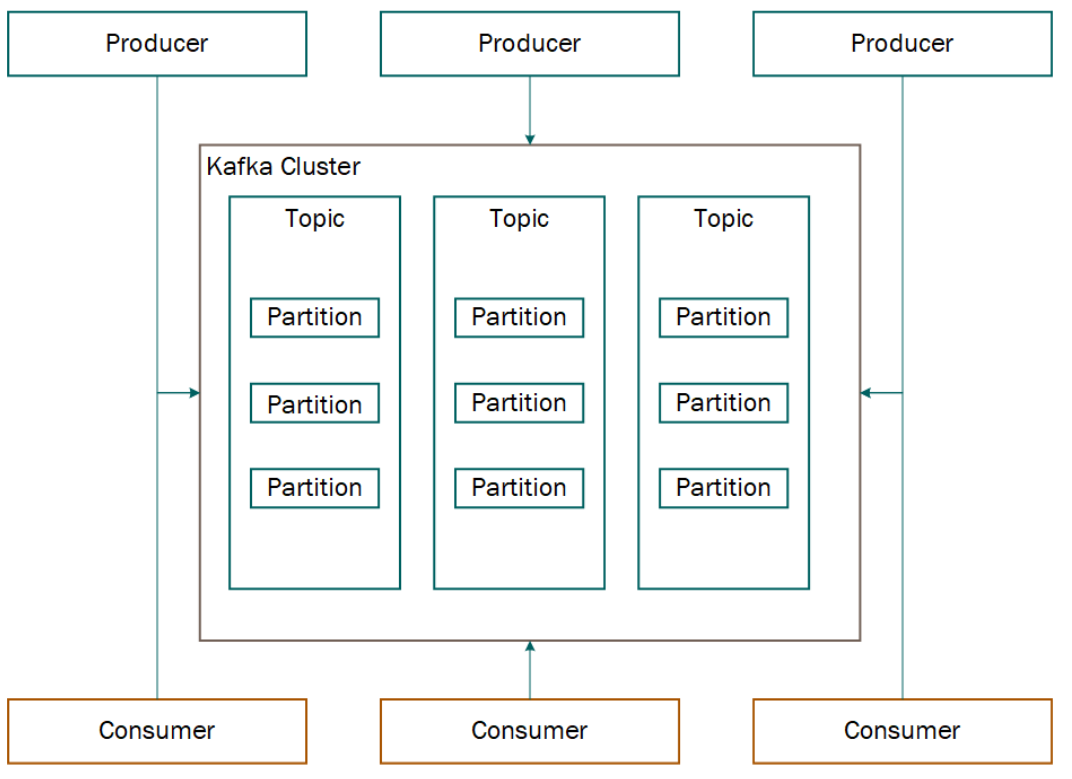
Figure 5. Apache Kafka basic